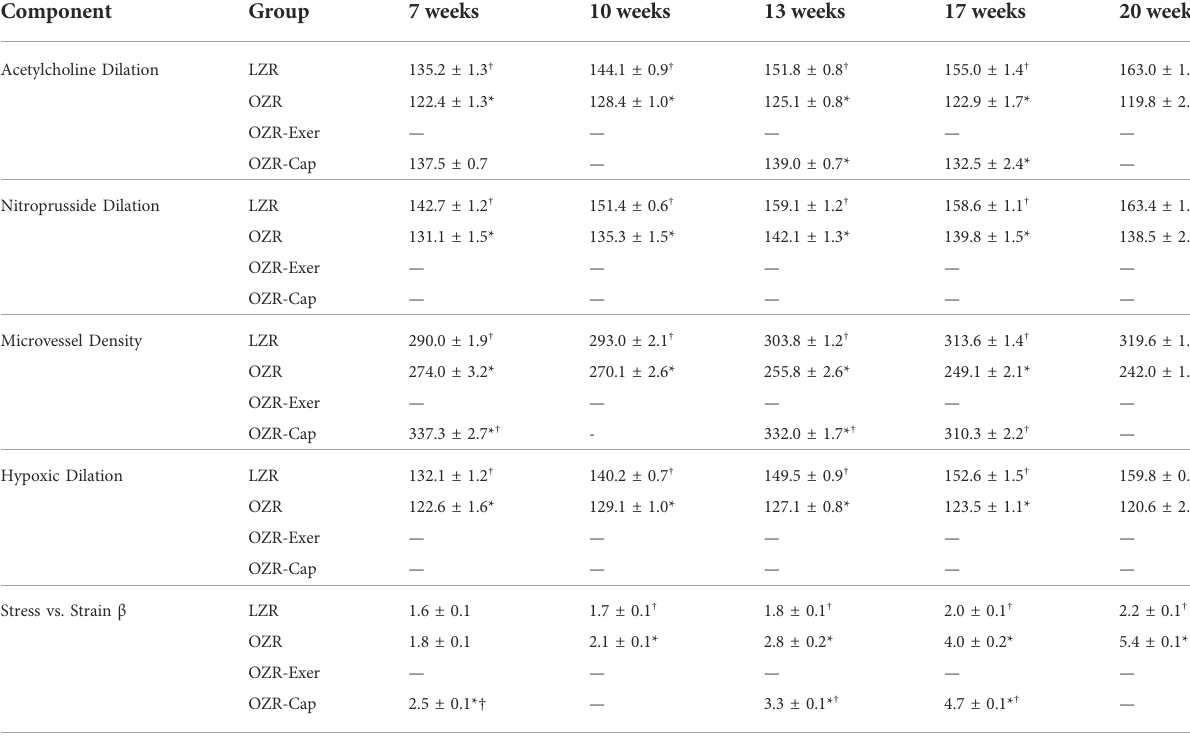
TABLE 5 Cerebral vascular component data, presented as mean ± SE, for the animal groups of the present study across all age. Component